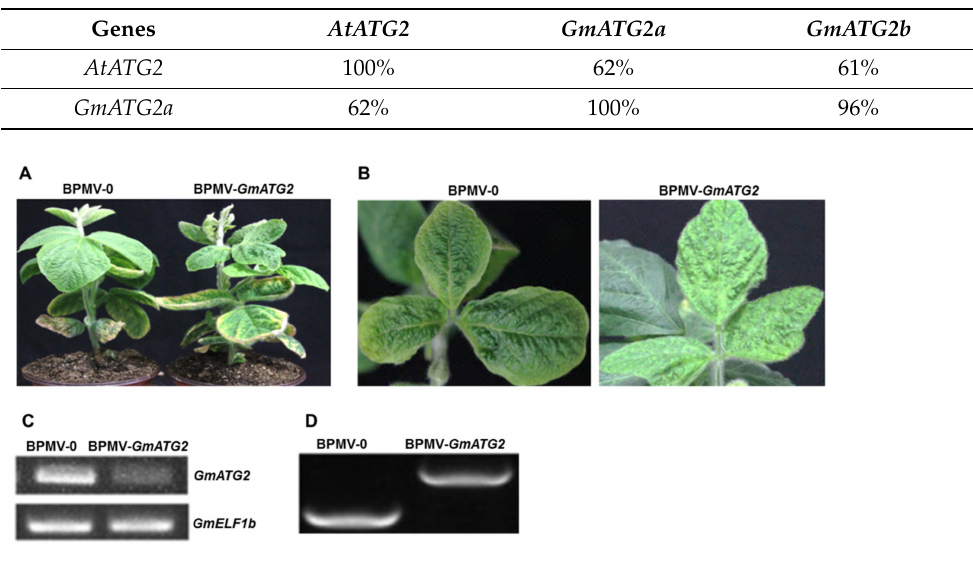
Figure 1. Phenotypes of silenced and control plants under normal conditions. ( A ) BPMV-0 and BPMV- GmATG2 plants shared a similar phenotype; ( B ) the BPMV- GmATG2 plants were not affected in growth and development, compared to BPMV-0. The leaves of the GmATG2- silenced plants and vector plants displayed obvious virus symptoms; there were bubbly protrusions around the veins, and the leaves are curled irregularly; ( C ) the transcript level of GmATG2 was significantly reduced in the silenced plants, compared to the BPMV-0 plants. GmELF1b is used as the internal reference gene. ( D ) RT-PCR fragment amplified from the BPMV- GmATG2 -silenced plants is larger than that amplified from the BPMV-0 plants, using a pair of primers on the BPMV2 vector. The increased length of the amplified fragment in the GmATG2- silenced plants is equal to the size of the inserted target gene fragment. The experiments were repeated at least twice, with similar results. At least 3 plants were used in each